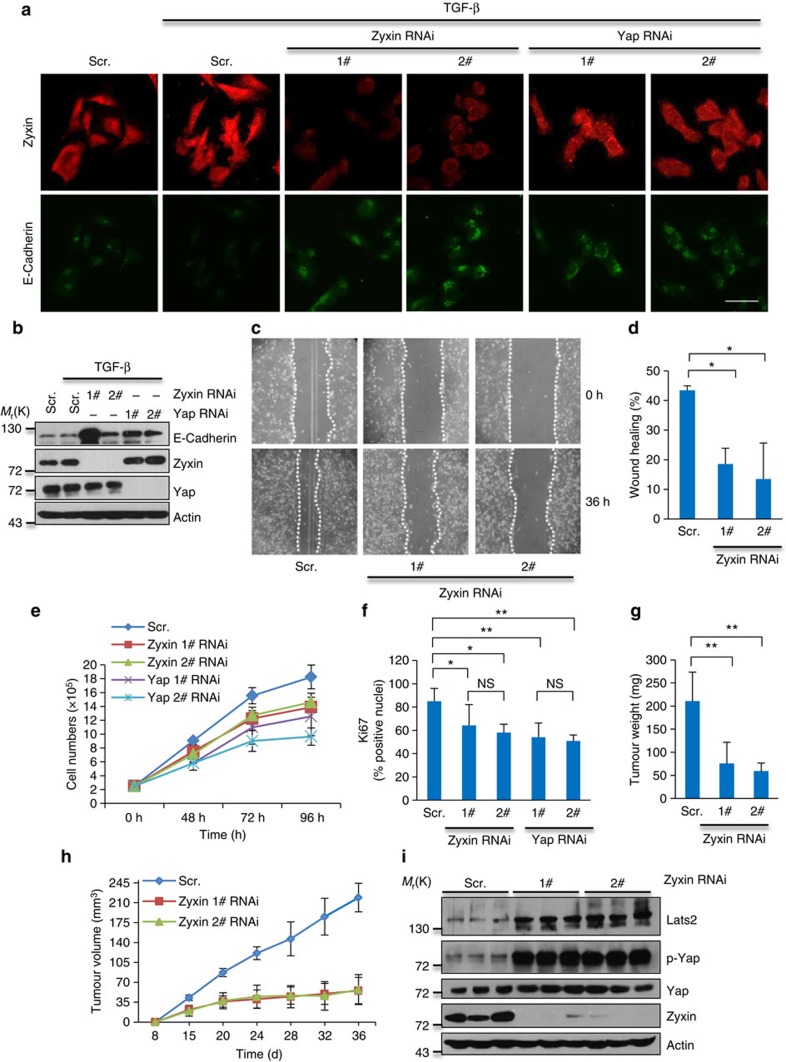
Zyxin is required for cell migration and tumour growth.(a,b) Zyxin-knockdown and Yap-knockdown MDA-MB-231 cells were treated with 5 ng ml−1 TGF-β for 12 h and stained with antibody against Zyxin and E-Cadherin (a), cell lysates were subjected for immunoblotting with indicated antibodies (b). Scale bars, 50 μm. (c,d) Migration of Scramble and Zyxin-knockdown MDA-MB-231 cells into the wound was monitored (c) and quantitative analysis of wound healing (d). The area was quantified by ImageJ software. (e) Cell proliferation rate of MDA-MB-231 cells bearing short hairpin RNAs (shRNAs) against indicated genes. (f) Quantitative analysis of Ki67-positive rate of MDA-MB-231 cells bearing shRNAs against indicated genes. (g,h) Tumour weight (g) and tumour growth curves (h) of mice with subcutaneous injection of MDA-MB-231 cells with or without knockdown of Zyxin. (i) Western blotting analysis of xenograft tumour tissues with the indicated antibodies. Data in e and f are the mean of n=3 independent experiments. n=5 mice per group in g and h. All error bars indicate s.d. *P<0.05, **P<0.01, NS, not significant. Two-tailed, unpaired Student's t-test.